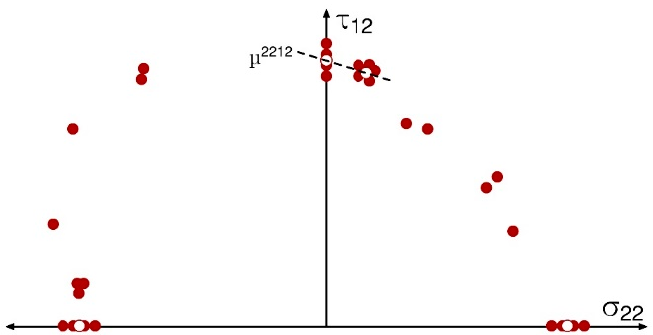
− σ plane. Red points indicate measured values (cid:2869)(cid:2870) (cid:2870)(cid:2870)